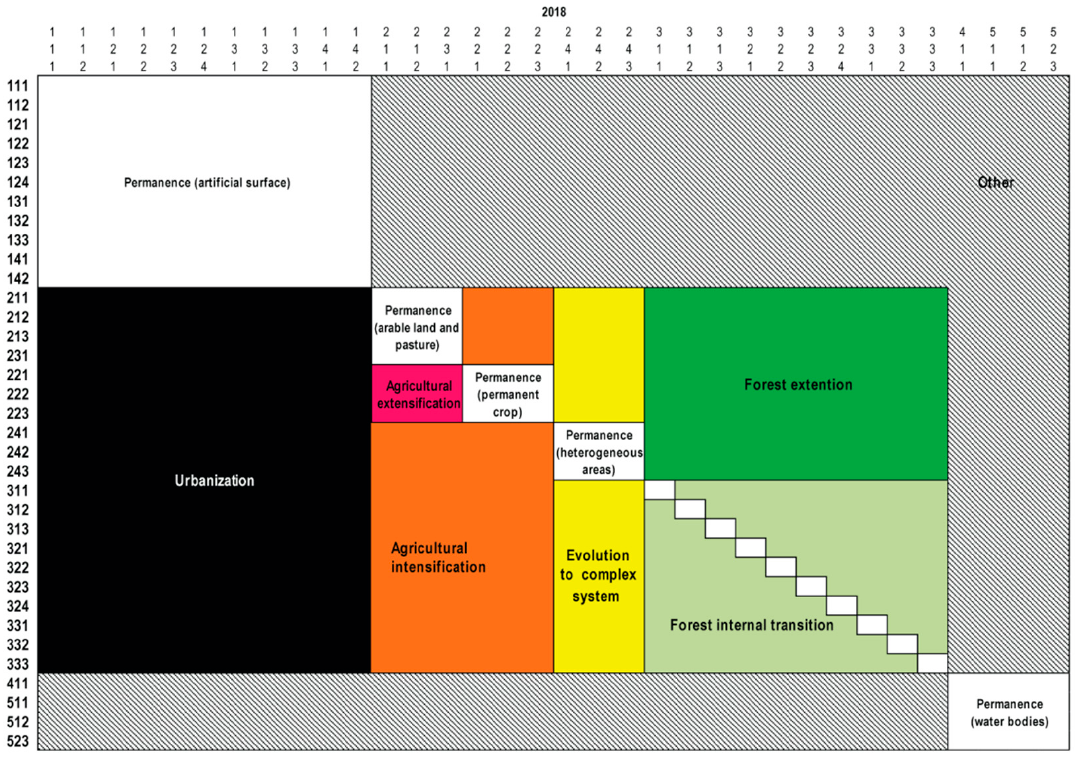
Figure 3. Land-use and land-cover (LULC) transition categories matrix (modified on [88]): urbanization (black), agricultural intensification (red), agricultural extensification (pink), evolution to complex systems (yellow), forest extension (green), forest internal transition (light green), other (gray), and permanence (white).